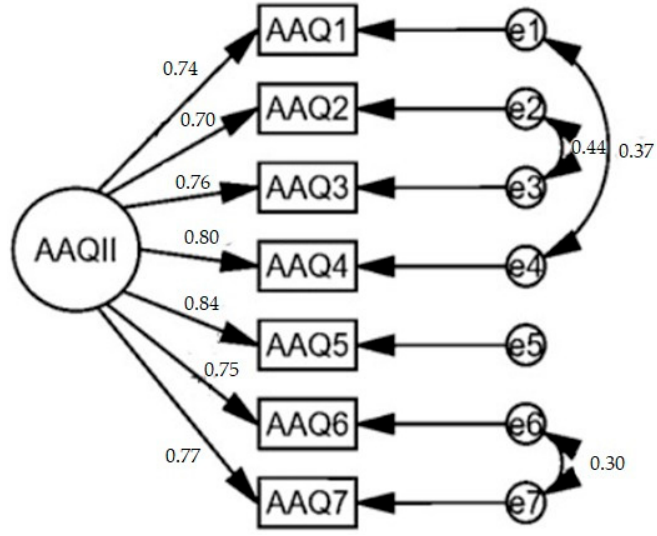
Figure 1. AAQ-II one-factor model.